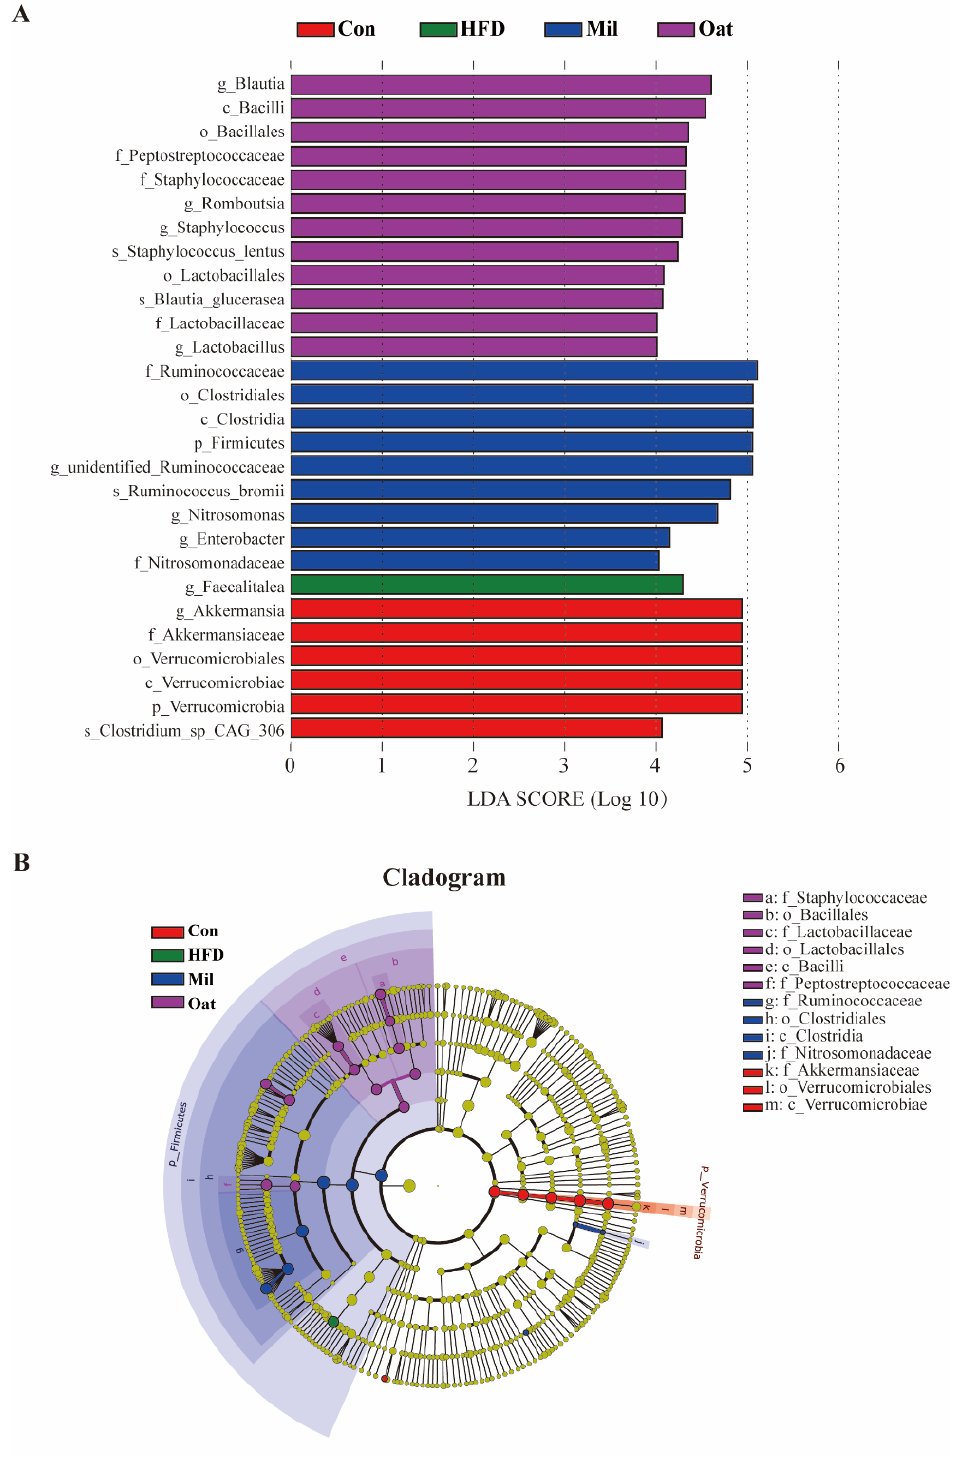
Figure 7. Linear discriminant analysis (LDA) effect size (LEfSe) analysis of the key genera of gut microbiota in high-fat diet fed rats. ( A ) Histogram of the LDA scores for differentially abundant bacterial taxa. ( B ) Cladogram visualizing the phylogenetic distribution of the gut microbiota community. Con group, a basal diet group; HFD group, a high-fat diet group; Oat group, HFD containing 22% oat group; Mil group, HFD containing 22% foxtail millet group; p, phylum; c, class; o, order; f, family; and g, genus.